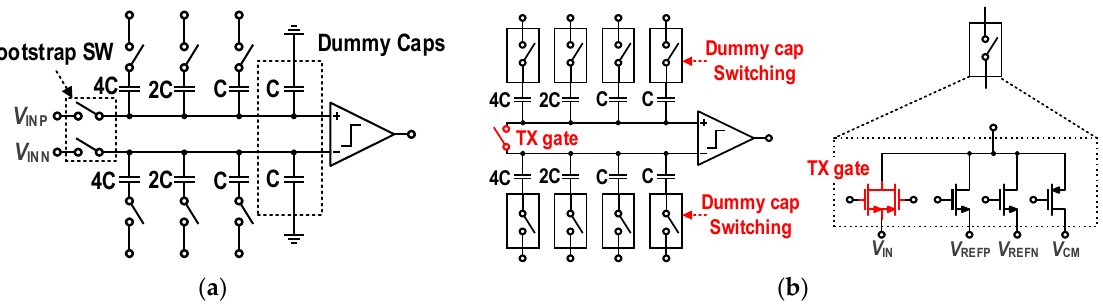
Figure 9. Conceptual diagram for successive approximation register (SAR) ADCs: ( a ) A conventional 4-bit top plate switching SAR; ( b ) Implemented 5-bit SAR ADC using the dummy capacitor switching technique.